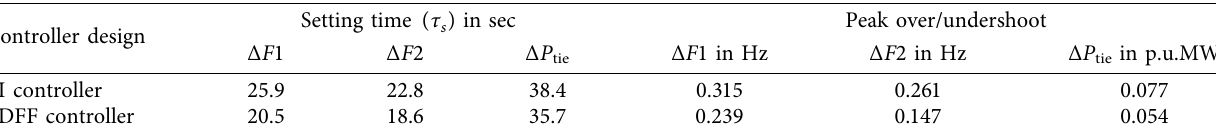
Table 3: Comparison of the system dynamic performance of the power system under investigation with different controllers (Setting 1). Controller design